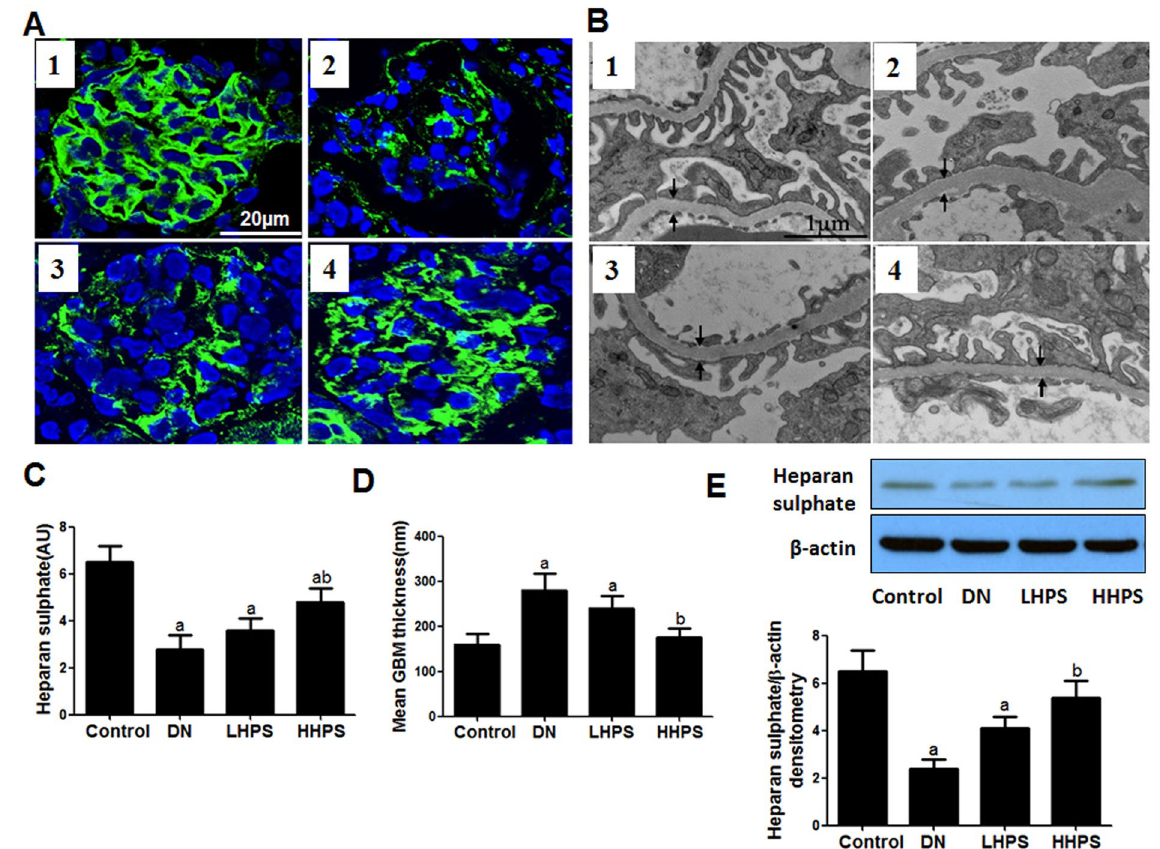
Figure 3. Hyperoside pre-treatment restored the decreased renal HS contents and attenuated GBM thickening in DN mice (n = 5). ( A ) The glomerular HS expression was determined by immunofluorescence staining. ( C ) The columns quantified the amount of immuno-reactive HS by NIH Image software. ( B ) GBM thickness was measured by transmission electron microscopy ( × 25000). ( D ) Quantifications of GBM thickness was presented in columns. ( E ) Western blot analysis of renal cortex HS protein levels and the columns showed the amount of HS protein levels relative to β -actin. Data are presented as mean ± SD. P < 0.05 is statistically significant. a Indicates significant vs. Control, b indicates significant vs.